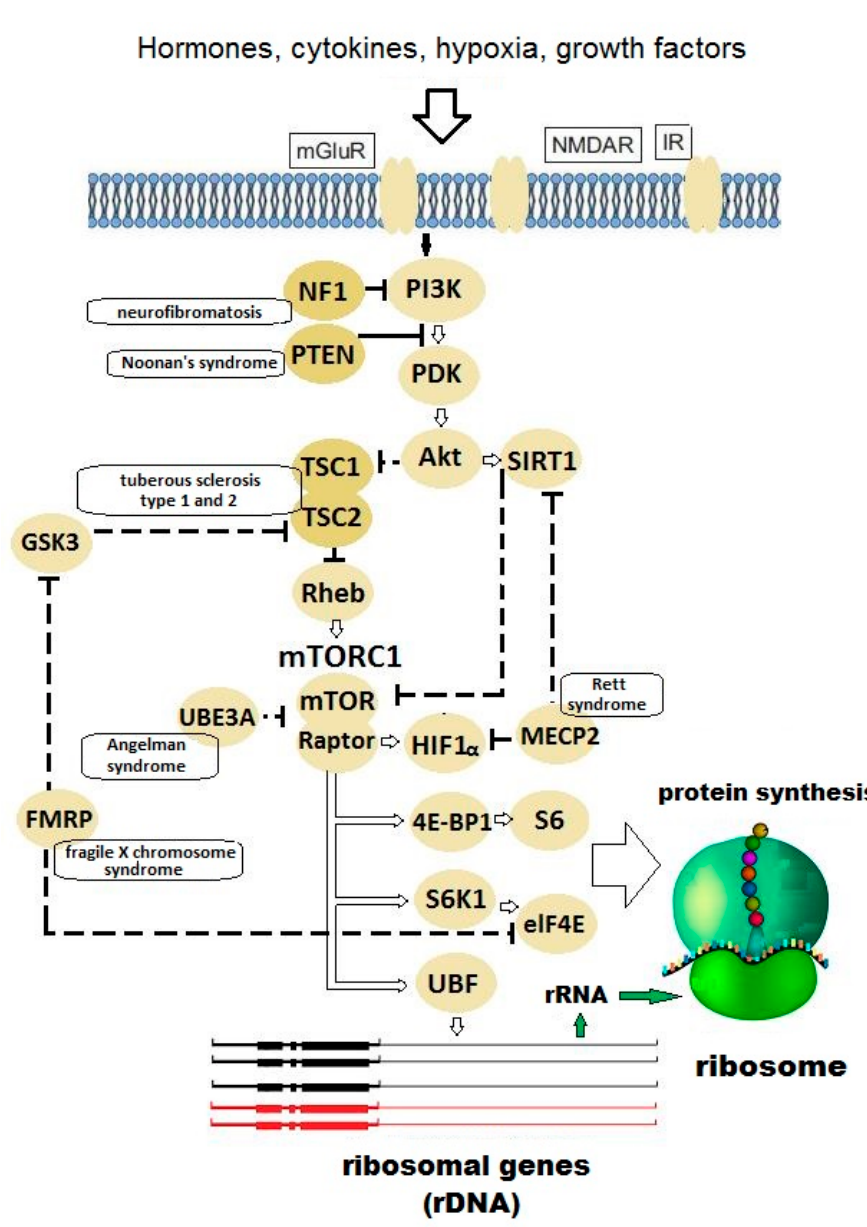
Figure 1. The molecular signaling pathways that control the pace of protein biosynthesis in ribosomes. An arrow stands for activation or synthesis of a product, a dashed line means suppression. Close to the key regulatory proteins, monogenic syndromes are indicated, which result from mutations in the gene for the relevant protein and cause mental retardation and autism in most (but not all) cases.